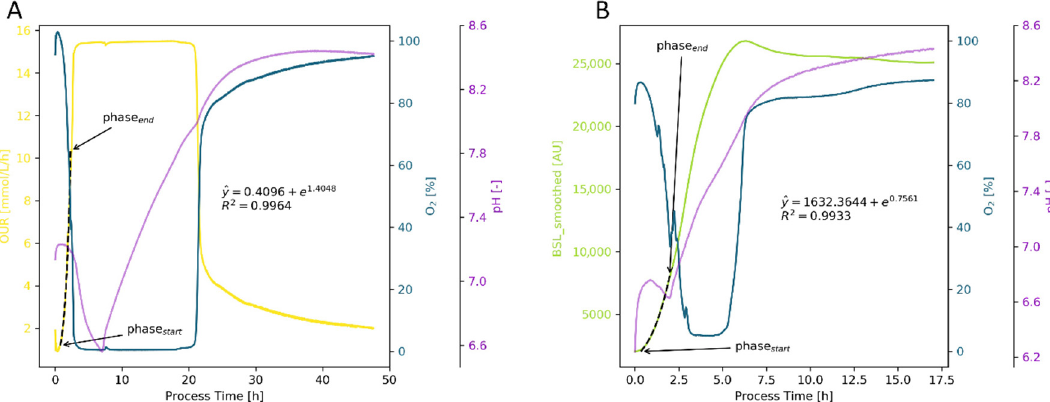
Figure 2. Evaluation of OUR and BSL for E. coli W3310 in TB ( A ) and LB ( B ) media. The OUR signal ( A , yellow line) in unbaffled 500 mL shake flasks, cultivated with 50 mL filling volume, 180 rpm shaking speed and 50 mm shaking amplitude, gives a good estimation of the growth rate with µ OUR, auto. = 1.4048 h − 1 . The oxygen limitation after 4 h is clearly visible in the OUR and the O 2 signal (blue line) until the glycerin has been completely consumed, which is indicated by a sharp increase in oxygen (21 h). The BSL signal (green line) in an experiment using LB ( B ) provides a good qualitative representation of the cultivation. However, the estimated growth rate µ BSL, auto. = 0.7561 h − 1 is significantly lower compared with the growth rates estimated offline (µ CDW, offline = 1.3237 h − 1 , Appendix B) and online based on the OUR (µ OUR, auto. = 1.2075 h − 1 , data not shown).